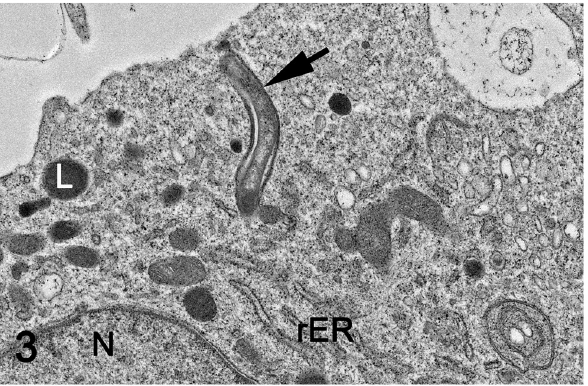
Fig 3. Monocyte-derived macrophage infected with L . intracellularis . Transmission electron microscopy. L . intracellularis organism was observed within phagocytic vesicle (black arrow), adjacent to the macrophage membrane. L: lysosome; N: nucleus; rER: rough endoplasmic reticulum.